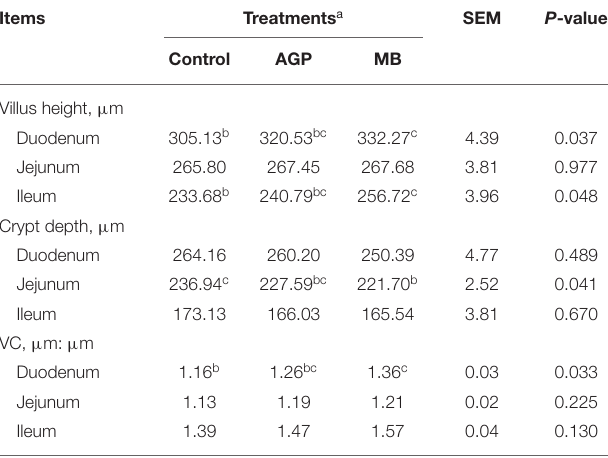
TABLE 5 | Effects of dietary Macleaya cordata extract and Benzoic acid supplementation on intestinal morphology of weaned piglets. Items